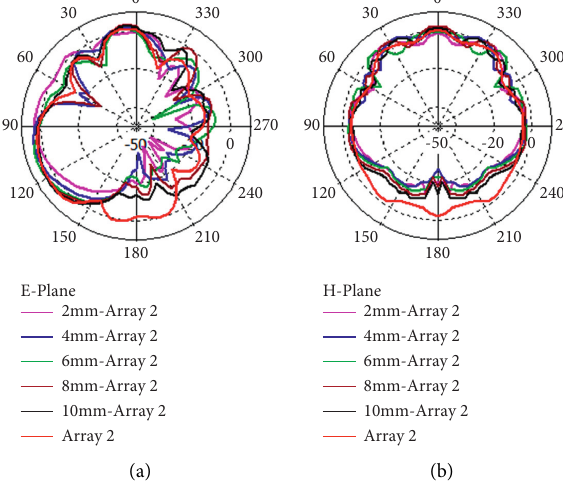
Figure 23: Array 2 on-body radiation pattern at 60GHz. (a) E-plane. (b) H-plane.